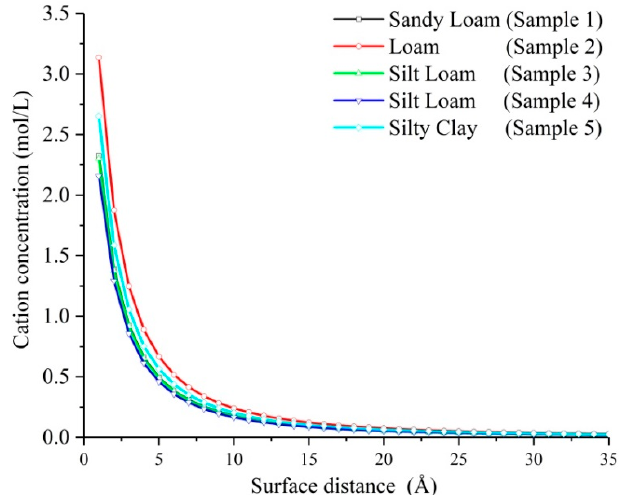
Figure 4. Variation of cation concentration in diffuse-layer with distance from adsorption layer-diffuse layer interface; the curves were drawn based on the calculation results from the Equation (5); physical properties of soils are shown in Table 1.